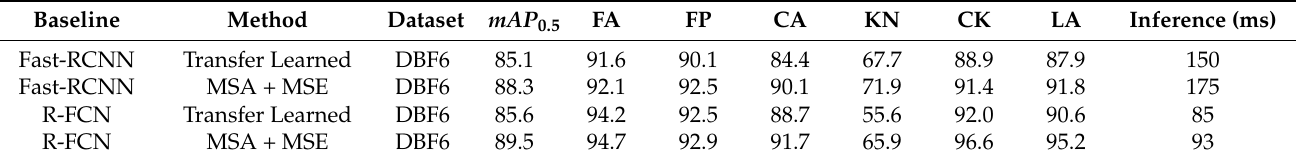
Table 6. DBF6 contrast experiments.